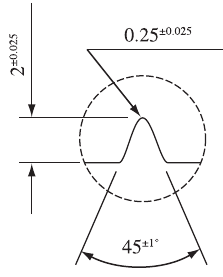
Figure 5. Size and geometry of the type A Charpy specimens according to ASTM E23-04.